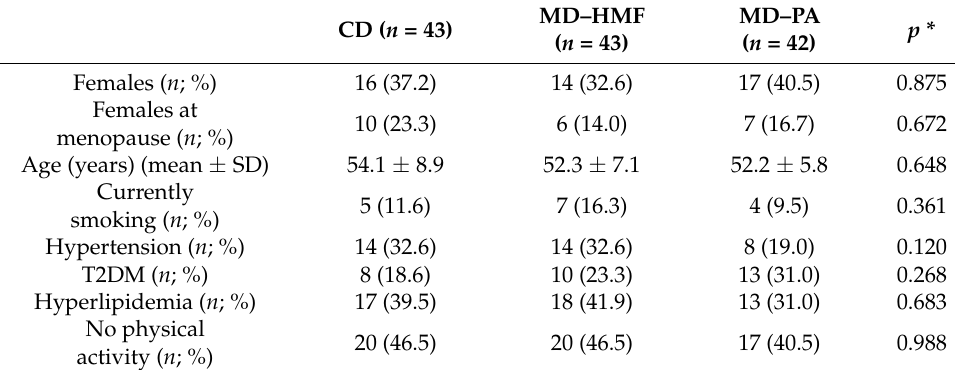
Table 1. Characteristics of participants at